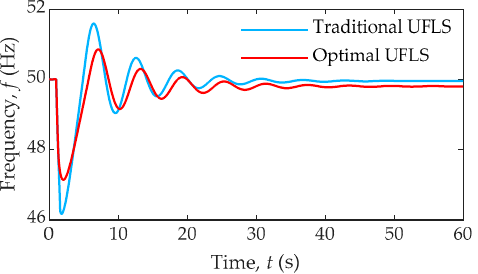
Figure 10. Frequency response in AURPS after disconnection of the Murun-Telmen 110 kV transmission line for low inertia—winter season scenario.